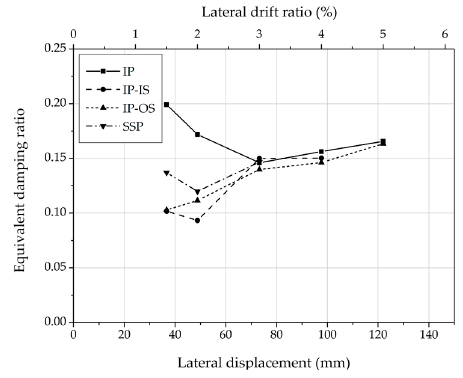
Figure 10. Variation in the equivalent damping ratio per load cycle with drift ratio.